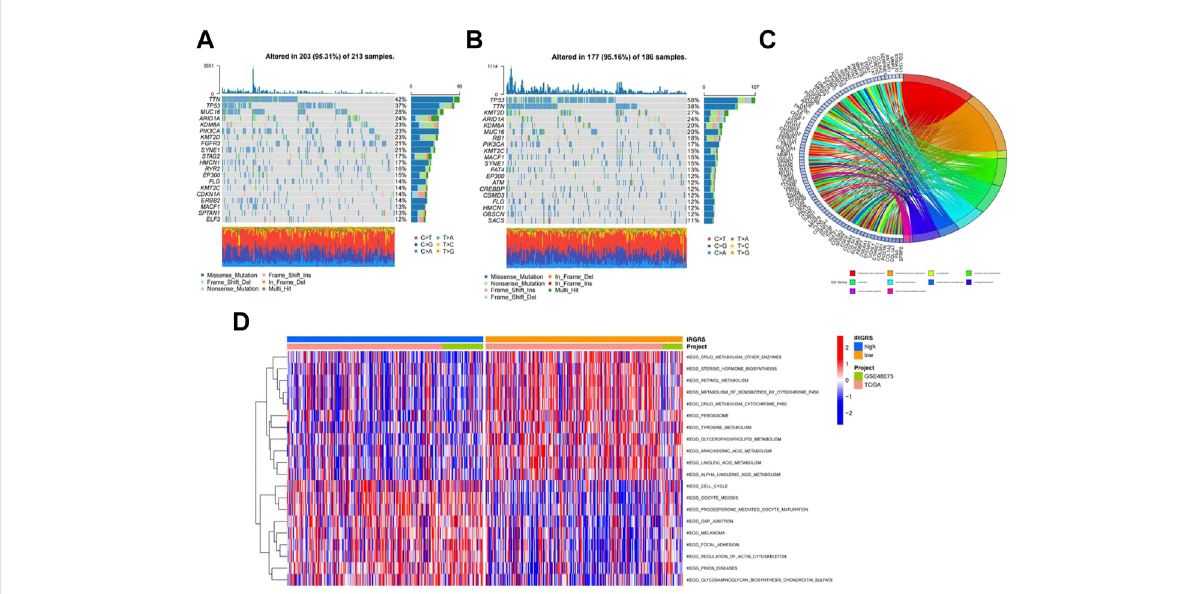
FIGURE 4 Molecular characteristic and functional enrichment analysis between high and low IRGRS groups. (A) . The waterfall plot of tumor somatic mutation established by those with low IRGRS groups, Mutated genes (rows, top 20) are ordered by mutation rate; Each column represented individualpatients.Theupperbarplotshowedtheoverallnumberofmutations.Therightbarplotshowedthepercentageofeachvarianttypeandthe mutation frequency of each gene. The color coding indicates the mutation type. (B) . The waterfall plot of tumor somatic mutation established by those with high IRGRS group. (C) . The GO terms are de fi ned as indicated color bars at the bottom and shown on the right of chord diagram, the involved genes are listed on the left. The genes associated ten signi fi cant signaling pathways. (D) . Heatmap by GSVA analysis between high and low IRGRSgroup.TheupperbarplotshowedtheIRGRSde fi nedsubgroups(high-IRGRSandlow-IRGRS)andtheoriginofdataset(TCGAandIMvigor210). The rows of the heatmap showed the activation of corresponding